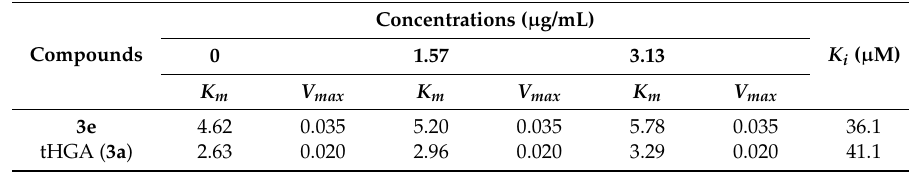
Figure 3. Lineweaver–Burk plot of 13-Hydroperoxyoctadeca-9,11-dienoic acid (13-HPOD) generated by soybean LOX-1 in the presence of ( a ) compound 3e and ( b ) tHGA ( 3a ) at 25 °C, pH 9.0. Concentrations of substrate used were 0.2, 0.3, 0.4, and 0.5 mM. Since compounds 3e and tHGA ( 3a ) are competitive inhibitors, there were no changes in maximal velocity. Hence, to calculate the inhibitor constant ( K i ), which is a measure of enzyme– inhibitor affinity or potency of different inhibitors, the slope of the Lineweaver–Burk plot was plotted against the inhibitor concentrations, where the intercept on the inhibitor axis gave the K i value [20]. The obtained K m , V max , and K i values are shown in Table 2. The inhibitor constant ( K i ) for compound 3e ( K i = 36.1) is lower than that of tHGA ( 3a ) ( K i = 41.1), which suggests that compound 3e has higher affinity toward the enzyme than tHGA ( 3a ). Table 2. K m (Michaelis–Menten constant), V max (maximum enzyme velocity), and K i (inhibitor constant) for the inhibition of soybean LOX-1 by the tested compounds.